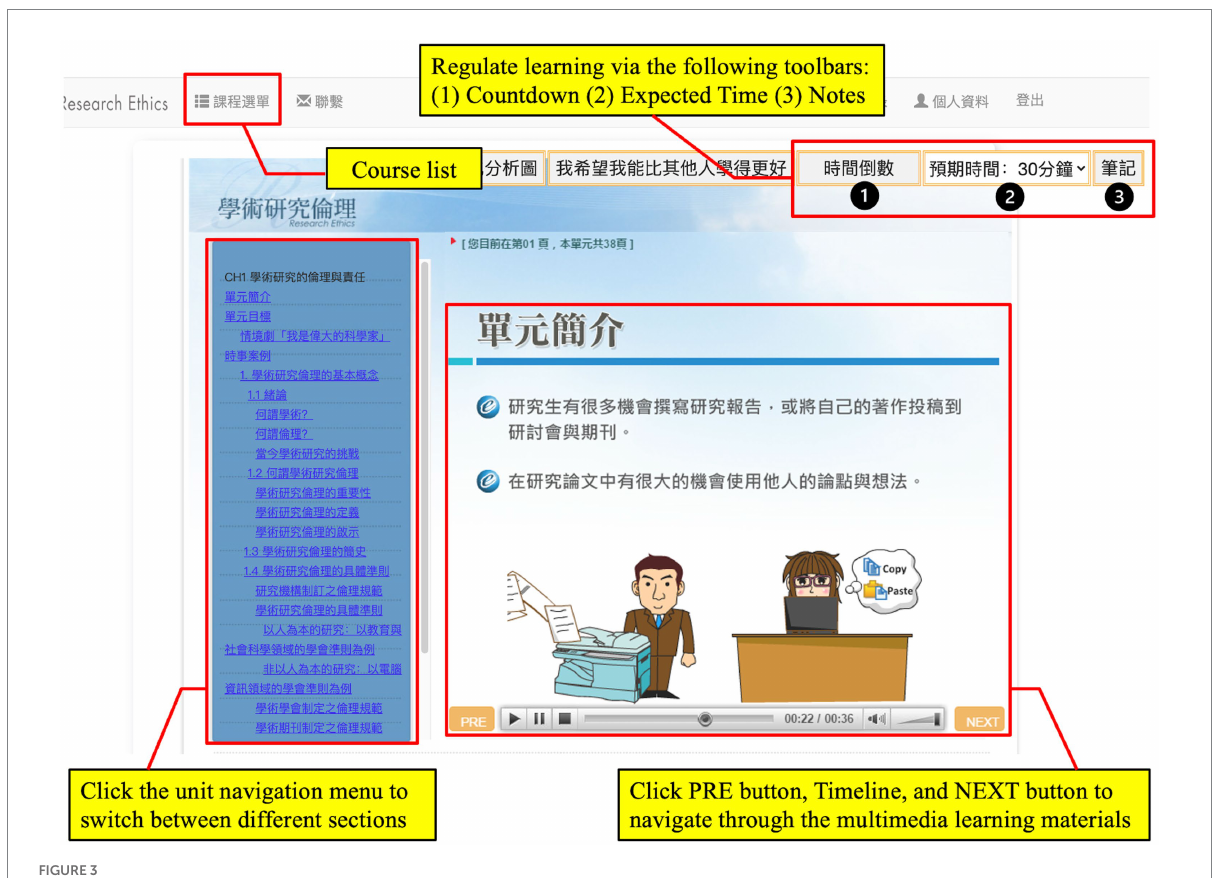
FIGURE 3 The user interface for “Countdown,” “Expected Time,” and